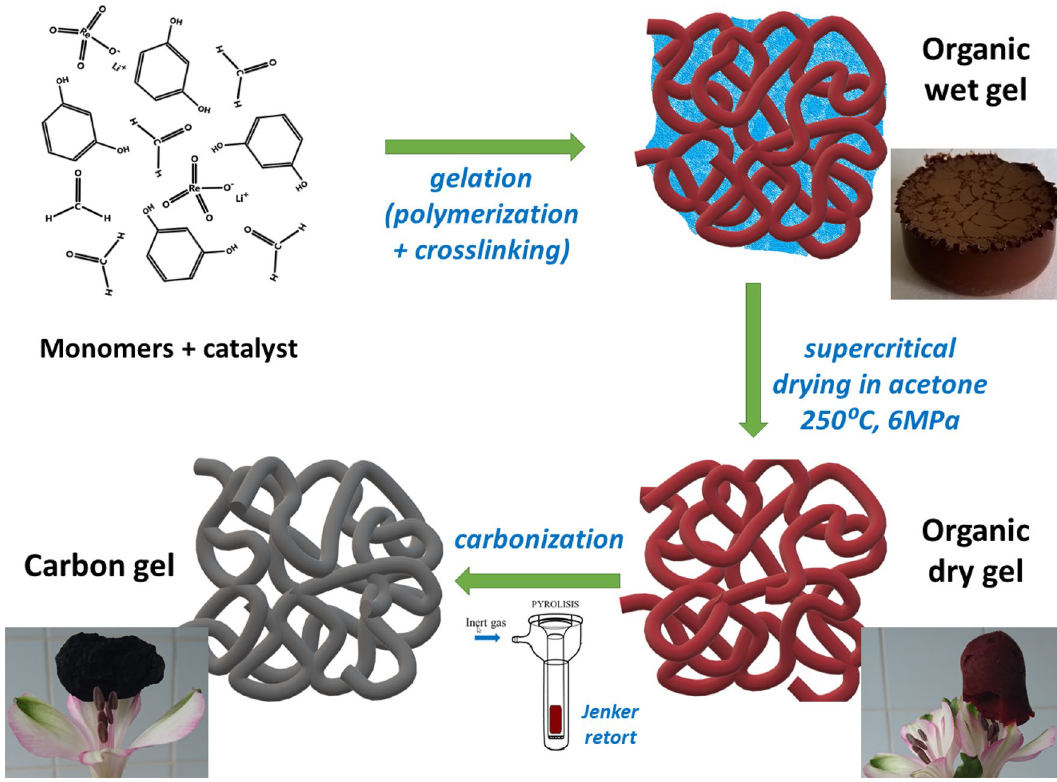
Fig. 1 Schematic presentation of carbon gel production